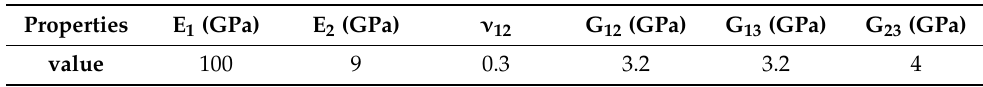
Table 2. Elastic properties of GRP